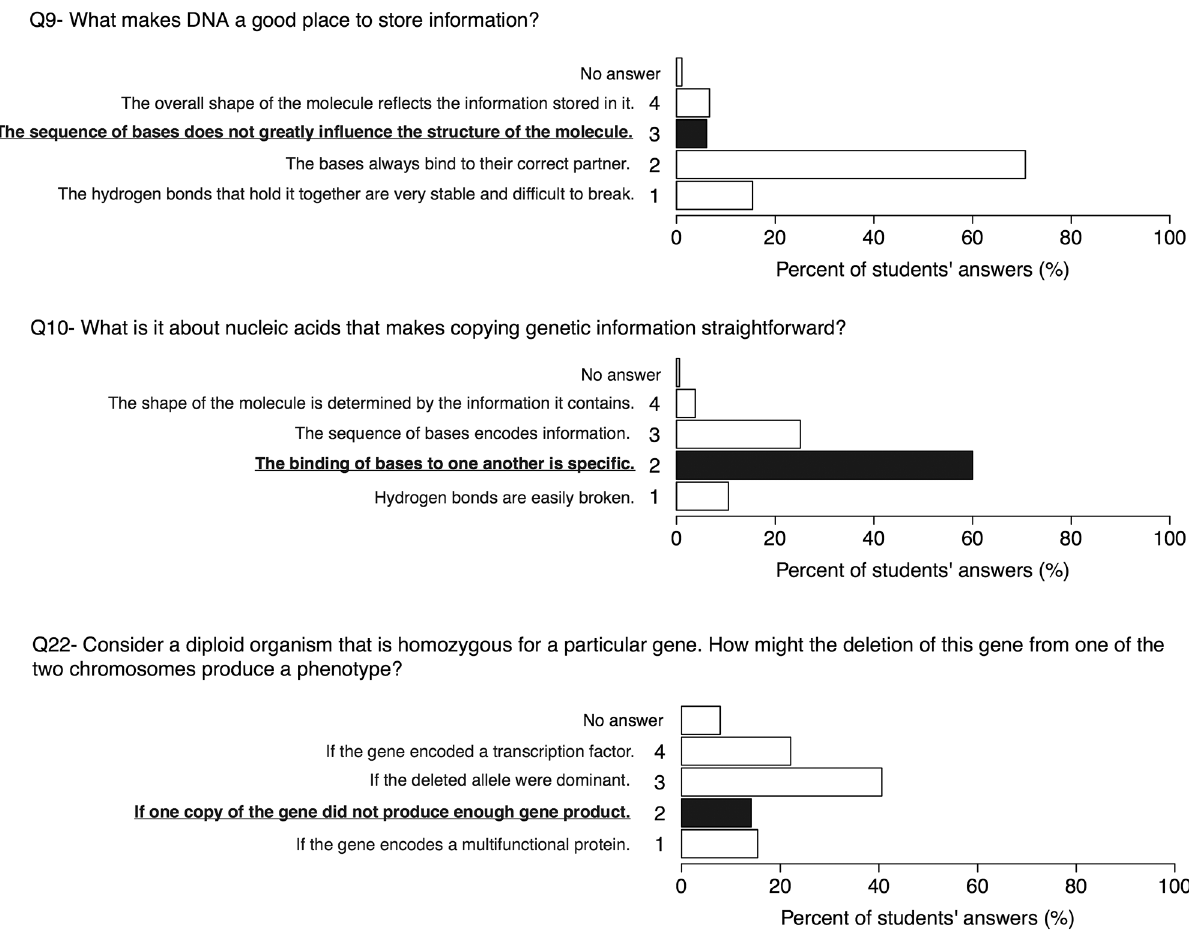
Fig 2. Results on questions 9, 10 and 22. Some misconceptionsrelated to the information storage function of DNA and the interconnection betweenmolecularpropertiesand geneticsare observedamongmany participants. The best answers are marked in